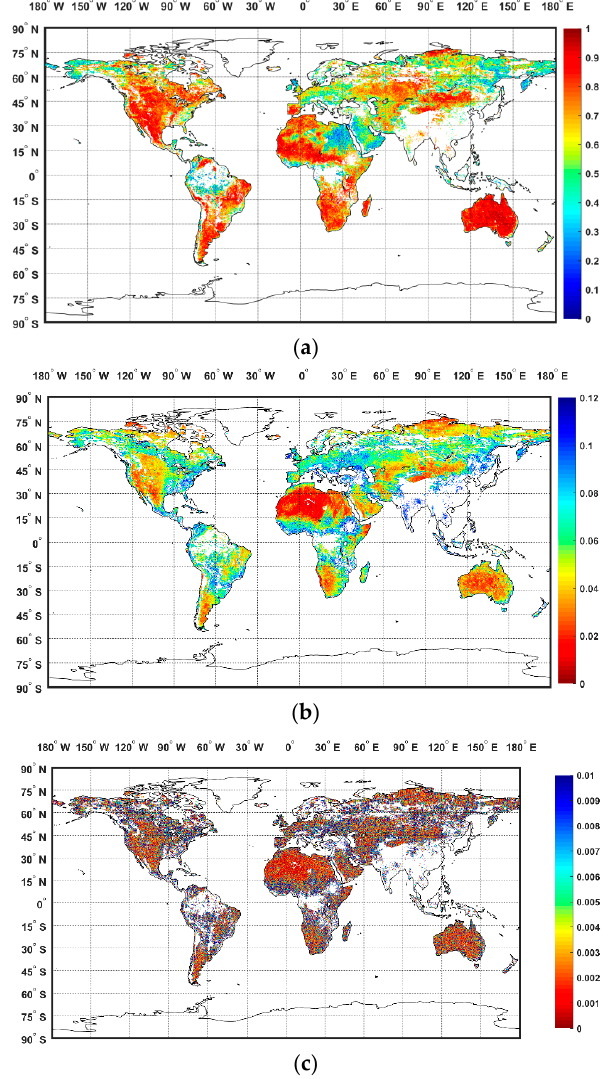
Figure 3. Statistics of trained NNsm vs. SMOSL3sm over the training period (July 2010–June 2011, and 2013): ( a ) CC and ( b ) RMSE (m 3 /m 3 ); ( c ) absolute value of Bias (m 3 /m 3 ); white areas over land indicate grids with a number of data (N) lower than 50.